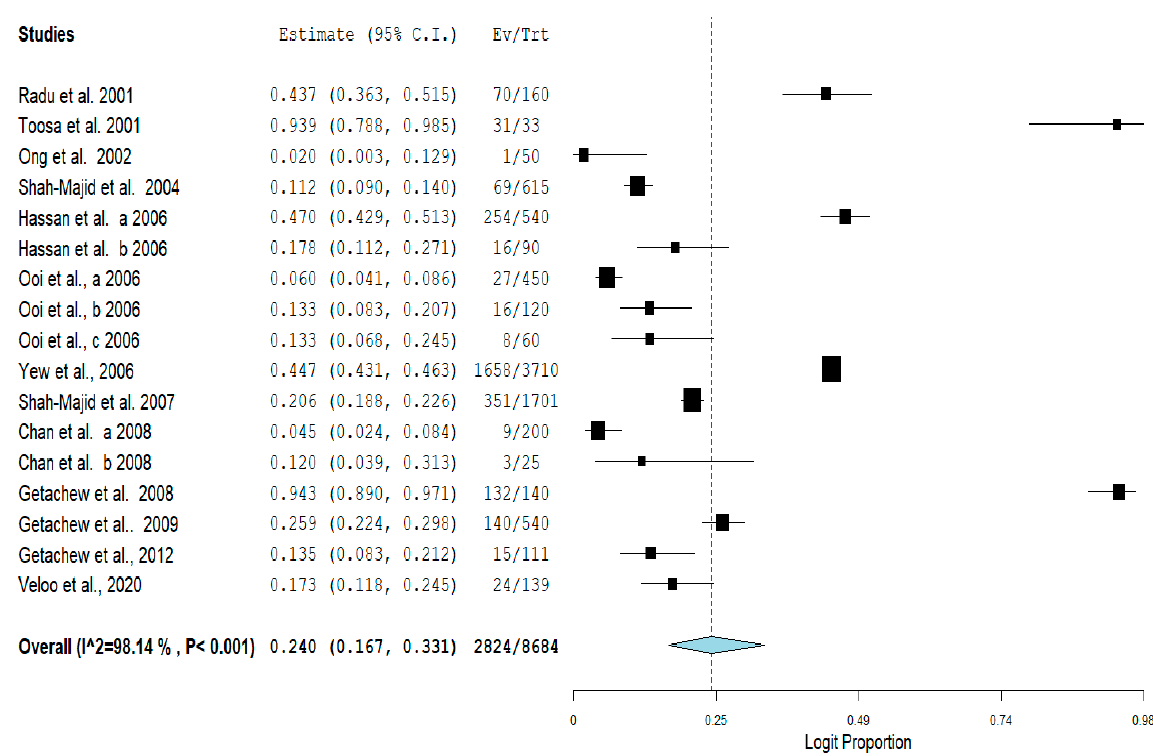
Figure 2. Forest plot showing the pooled prevalence of VRE in poultry in Malaysia.